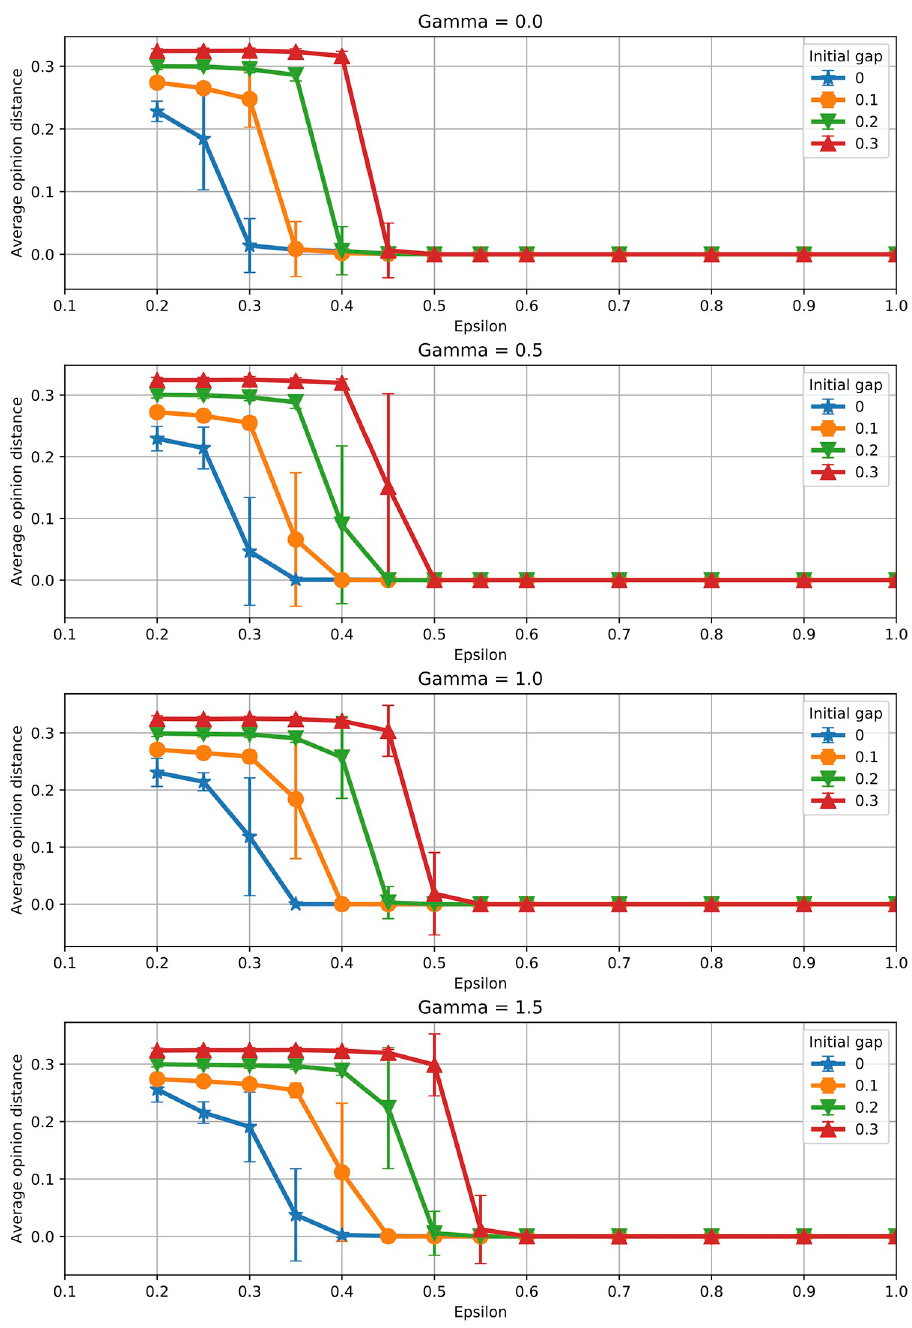
Fig 10. Initial condition: Opinion distance. Effect of the initial condition on the average opinion distance (averages over 100 runs).